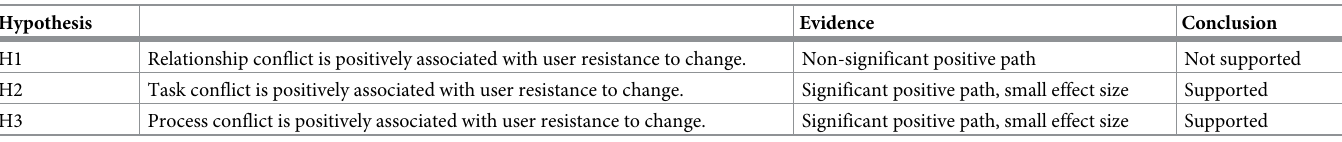
Table 5. Hypotheses testing